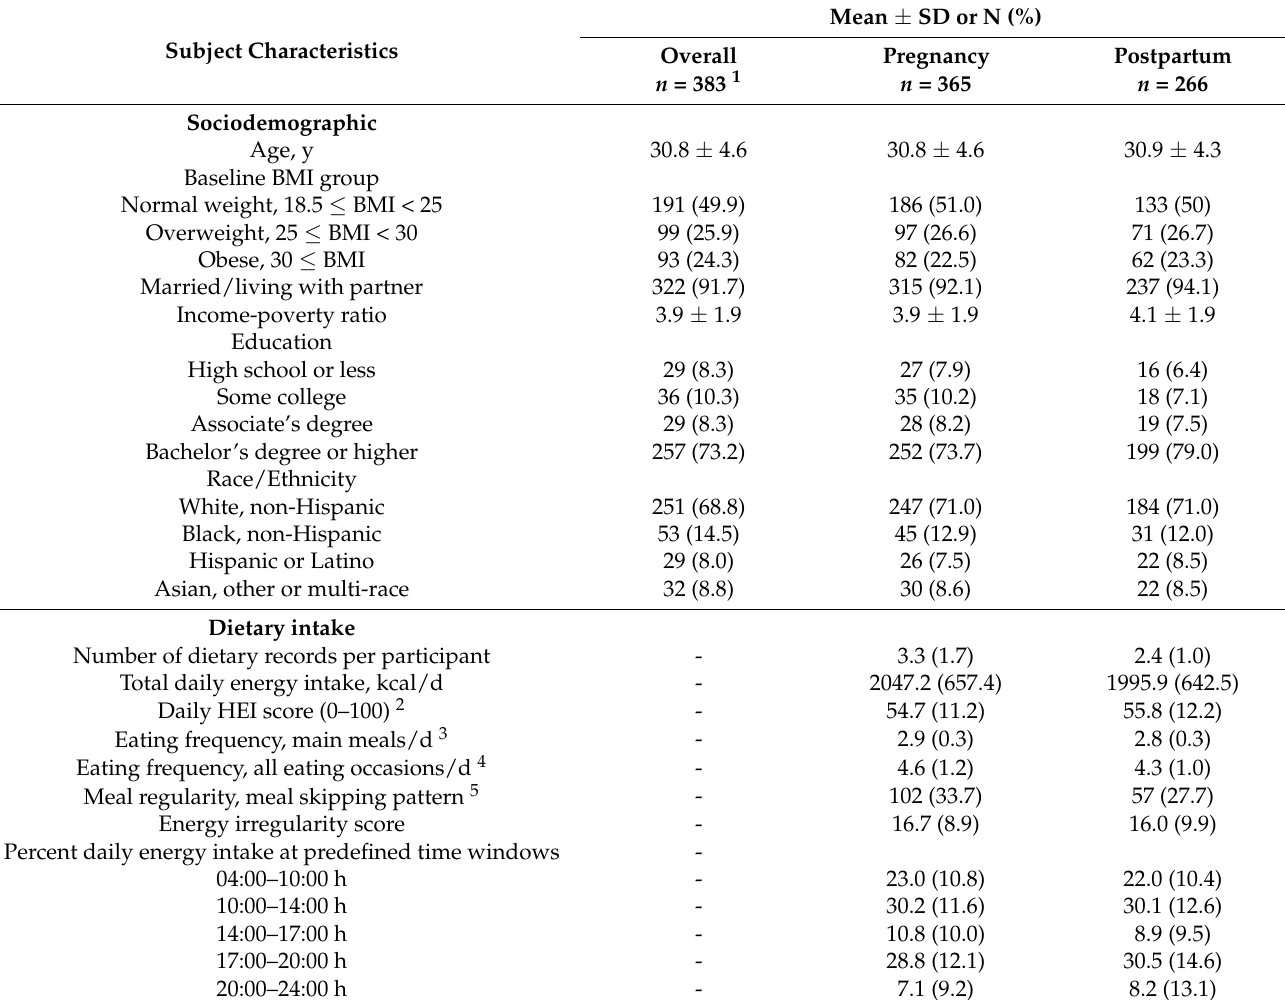
Table 1. Sample characteristics of participants with dietary recall data in pregnancy and/or postpar- tum in